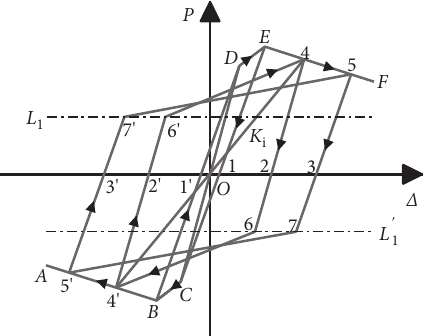
Figure 24: Restoring force model for STHCCs.